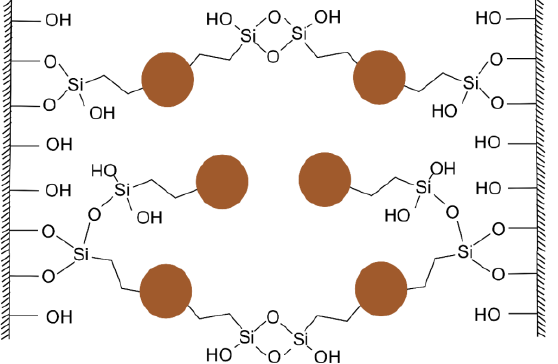
Figure 8. Interplay of two types of interactions, which provide for the efficiency of the APTE-mod- ified HS as soil conditioner: adhesion due to formation of siloxane bonds and a decrease in wetta- bility due to immobilization of hydrophobic, aromatics-rich domains of coal HS (shown as brown